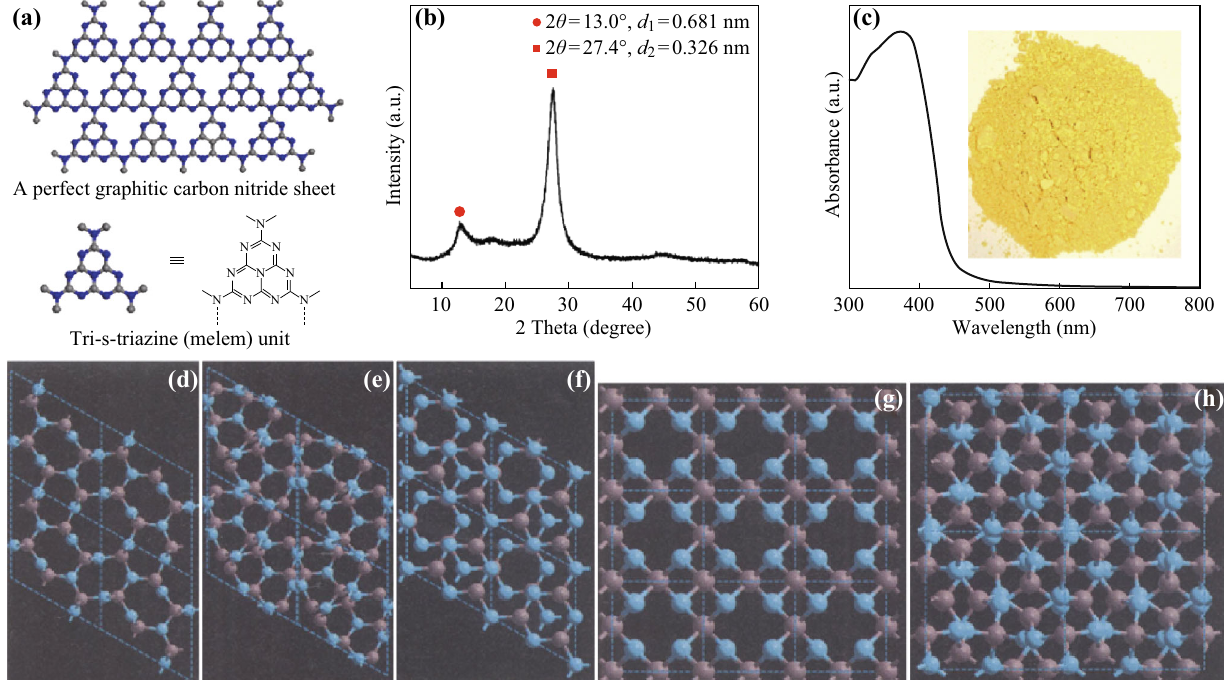
Fig. 2 Crystal structure and optical properties of graphitic carbon nitride. a Schematic diagram of a perfect graphitic carbon nitride sheet constructed from melem units. b Experimental XRD pattern of the polymeric carbon nitride, revealing a graphitic structure with an interplanar stacking distance of aromatic units of 0.326 nm. c UV-visible diffuse reflectance spectrum and image ( inset ) of g-C 3 N 4 . Reprinted with permission from Ref. [5]. Copyright 2009 Nature Publishing Group. Representation of the b -C 3 N 4 ( d ), a -C 3 N 4 ( e ), graphite-C 3 N 4 ( f ), pseudocubic-C 3 N 4 ( g ), and cubic-C 3 N 4 ( h ). The carbon and nitrogen atoms are depicted as gray and blue spheres , respectively, from Ref. [4]. Copyright 1996 American Association for the Advancement of Science. (Color figure